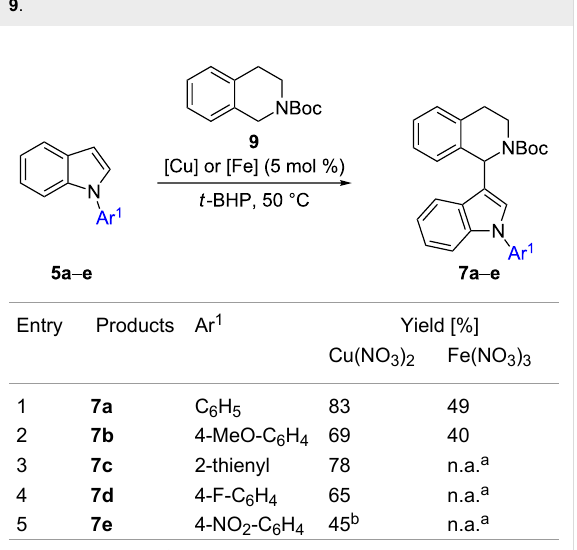
Table 5: Scope of the reaction of N-arylindoles 5a–e with N -Boc-THIQ 9